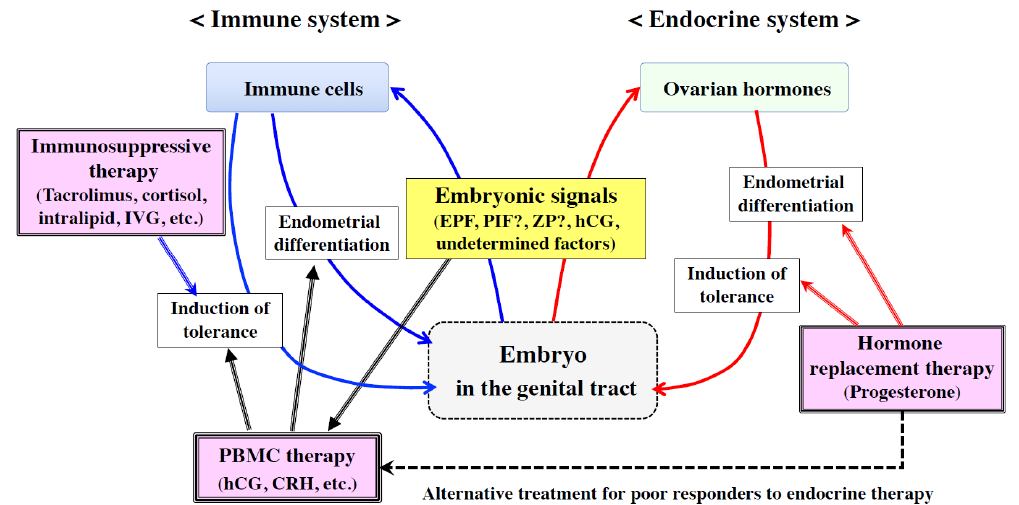
Figure 4. Strategy of immune therapy using embryonic signals. Embryonic signals from the genital tract act on both endocrine (red arrows) and immune (blue arrows) systems to induce endometrial differentiation and immune tolerance. To assist the endocrine system, hormone replacement therapy was recommended to promote endometrial receptivity (red triple lines), whereas to minimize immune rejection, immunosuppressive agents were administered to elicit immune tolerance (blue triple line). On the other hand, to induce sufficient endometrial differentiation and receptivity in infertile patients who poorly respond to endocrine stimulation (black dotted line), intrauterine administration of embryonic signal-activated peripheral blood mononuclear cells (PBMCs) is one of the promising approaches that may induce favorable endometrial differentiation and inflammatory reactions together with a favorable immune environment for embryo implantation (black triple lines).